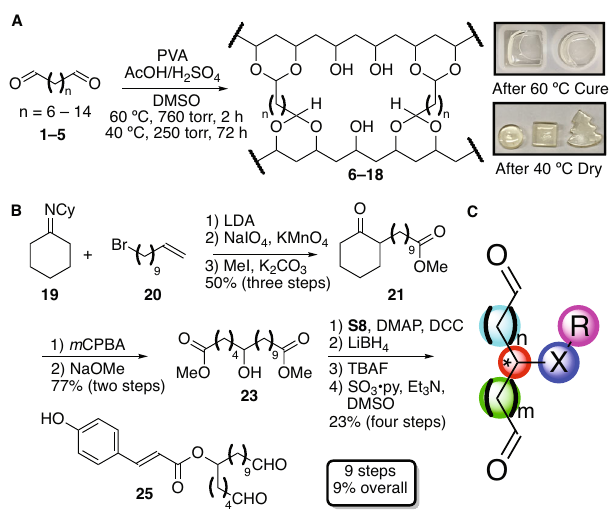
Fig. 2 Chemical synthesis of sporopollenin analogues. A Simpli fi ed sporopollenin analogue 6 – 18 synthesis, B synthetic preparation of substituted crosslinker 25 , and C summary of potential crosslinker analogue route divergence (teal/green: linker length modi fi able via selection of cyclic ketone and bromoalkene, red: stereochemistry set via enantioselective alkylation or ring expansion, blue: heteroatom altered via selection of ring expansion conditions, purple: substituent varied via esteri fi cations, amide couplings, alkylations, inter alia